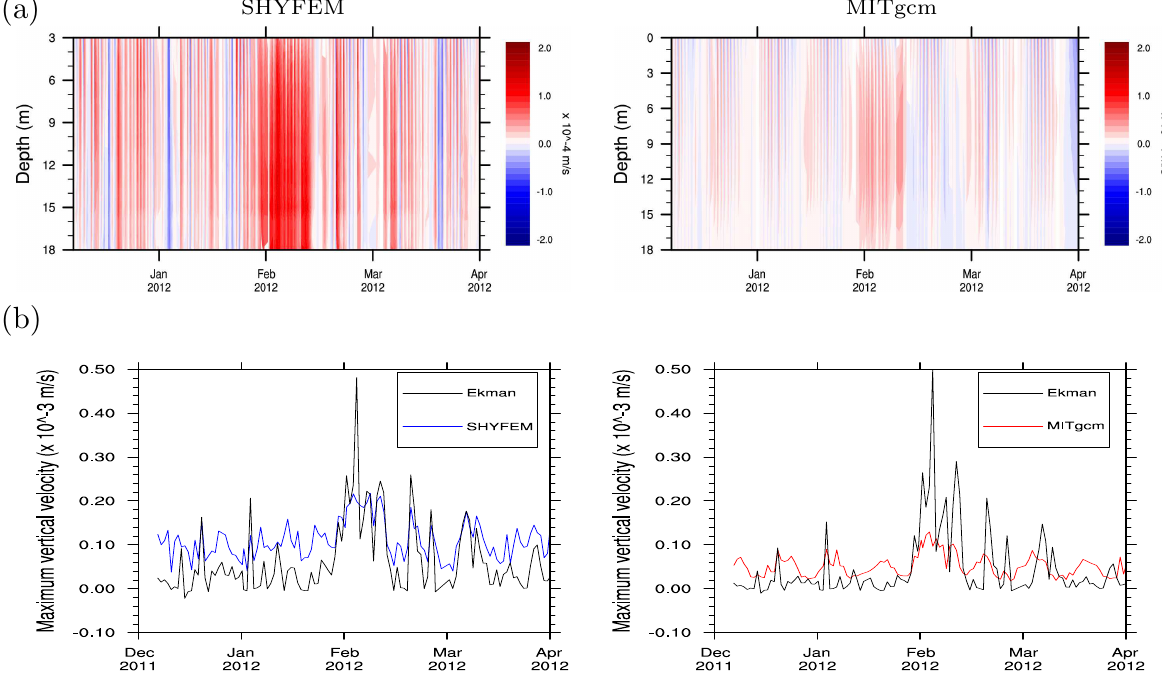
Figure 11. (a) Time series of depth profiles of vertical velocity averaged over the coastal area of the Gulf of Trieste, with depth lower than 18m, and (b) time series of maximum daily Ekman wind curl and daily maximum of net vertical velocity for SHYFEM and MITgcm.